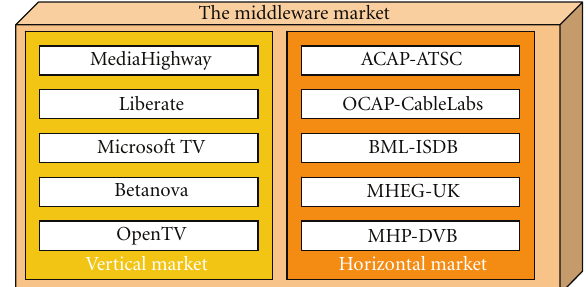
Figure 3: The Fragmented Proprietary versus Open DTV Middle- ware